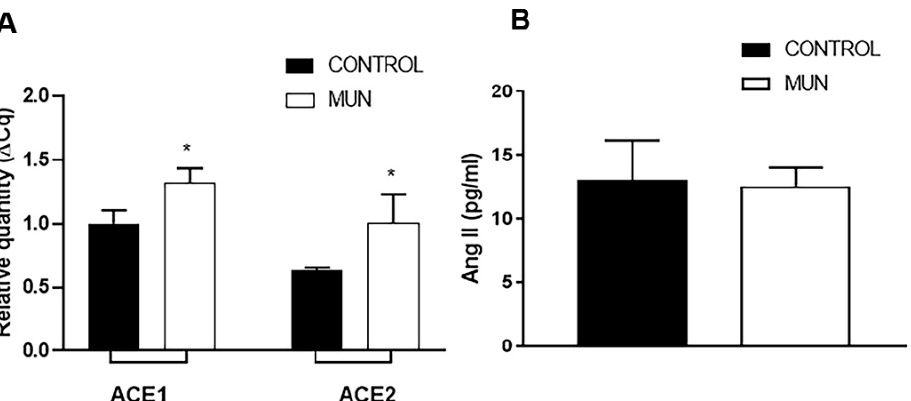
Figure 1. Influence of fetal undernutrition on content of vascular ACE/ACE2 and on plasma Ang II levels in 6-month-old male offspring from rats exposed to maternal undernutrition during preg- nancy (MUN) and rats fed ad libitum (CONTROL). ( A ) Expression of ACE and ACE2 in mesenteric arteries from MUN and CONTROL rats. RT-PCR analysis of transcripts for ACE/ACE2. Results are normalized to the 28s gene and fold changes between MUN and CONTROL are expressed as mean ± s.e.m., from 6 rats in each group. Significant differences from CONTROL rats: * p < 0.05. ( B ) Plasma concentration of Ang II from MUN and CONTROL rats. Values are mean ± s.e.m., from 8 rats in each group. Significant differences from CONTROL rats: * p < 0.05.